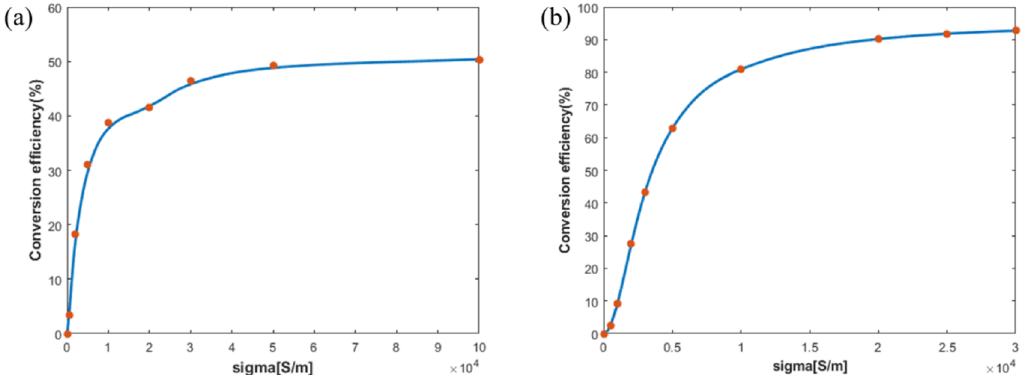
Fig. 6. The relationship between gallium arsenide conductivity and conversion ef fi ciency (a) Transmissive metasurface circularly